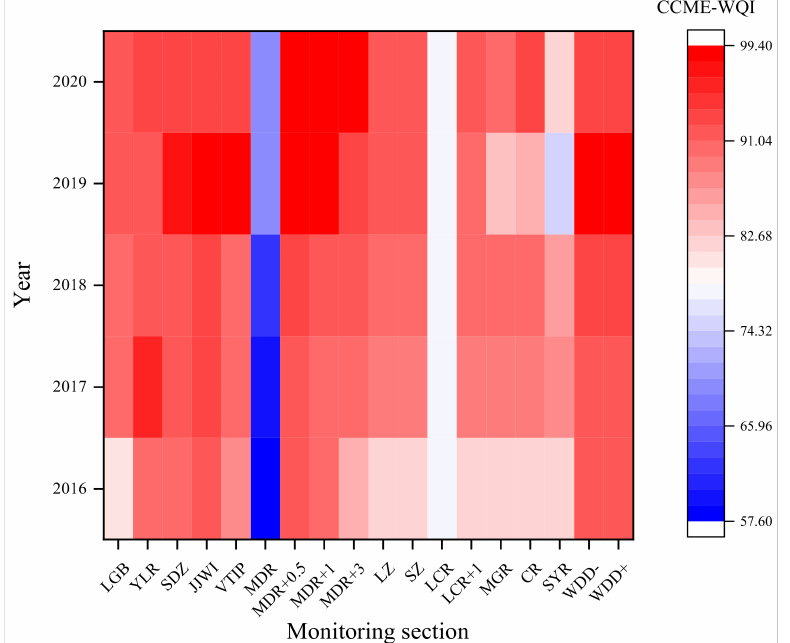
Figure 4. Spatial and temporal variation in Canadian Council of Ministers of the Environment Water Quality Index (CCME-WQI) values in the Wudongde Dam from 2016 to 2020. Excellent (95–100), good (80–94), fair (65–79), marginal (45–64), and poor (0–44). Luoguo Bridge, LGB; Yalong River, YLR; Sanduizi, SDZ; Jinjiang Water Intake, JJWI; Vanadium Titanium Industrial Park, VTIP; Madian River, MDR; 0.5 km downstream of Madian River, MDR + 0.5; 1 km downstream of Madian River, MDR + 1; 3 km downstream of Madian River, MDR + 3; Lazha, LZ; Shizhuang, SZ; Longchuan River, LCR; 1 km downstream of Longchuan River, LCR + 1; Mengguo River, MGR; Chen River, CR; Shenyu River, SYR; upriver from the Wudongde Dam, WDD-; downstream of the Wudongde Dam,